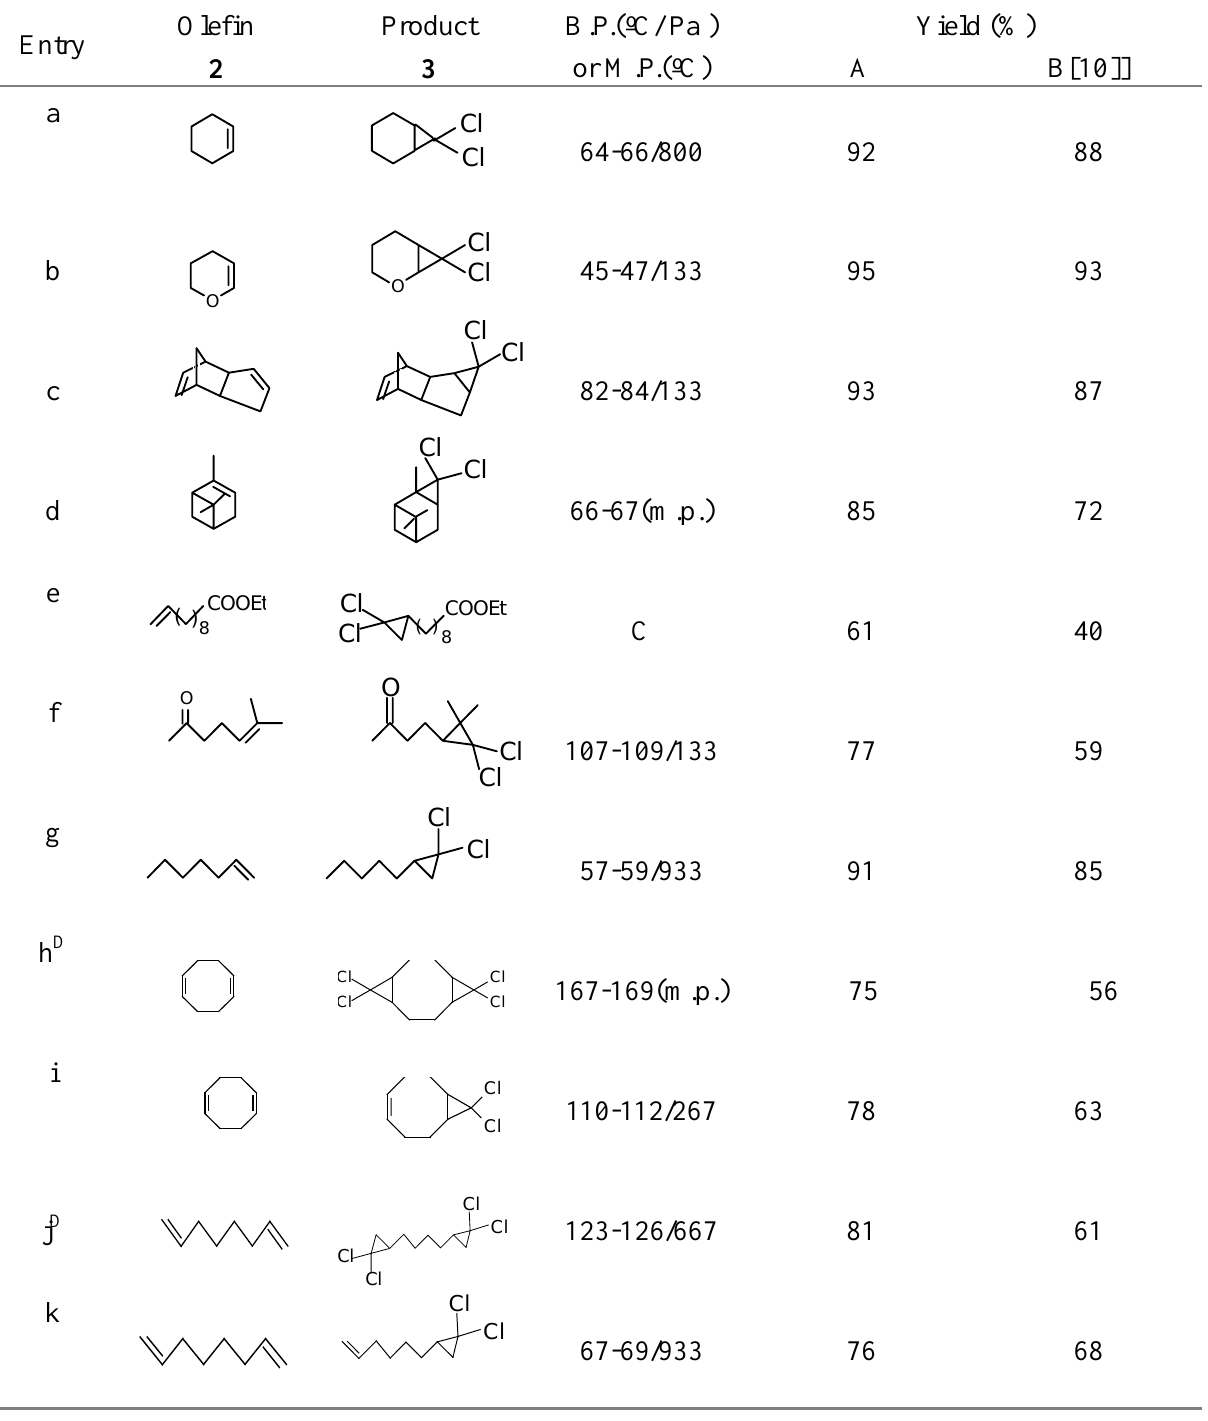
Table 1. Gem-dichlorocyclopropane Derivatives Prepared using Ultrasonic